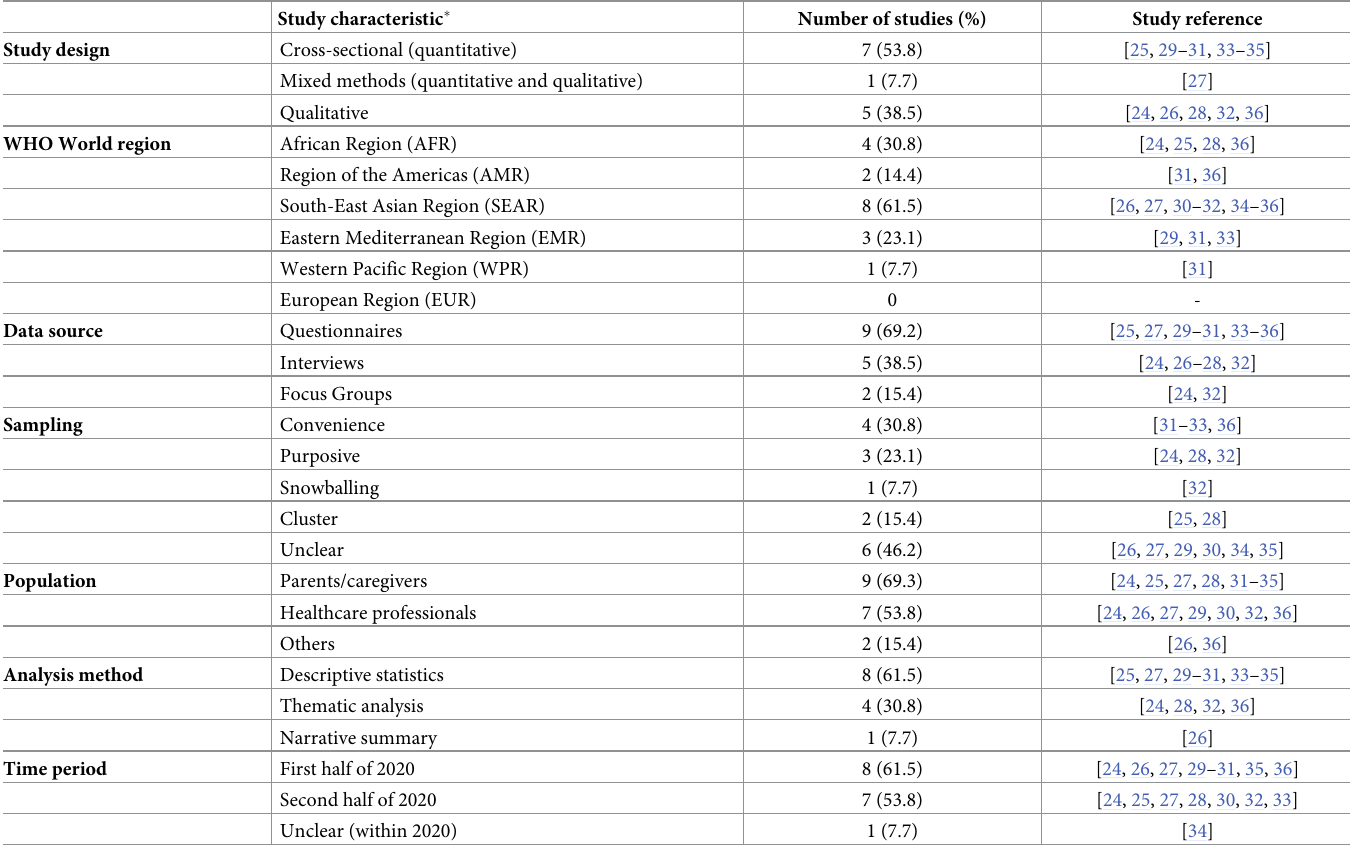
Table 2. Summary of study characteristics for studies reporting reasons for disruptions to routine immunisations (n =